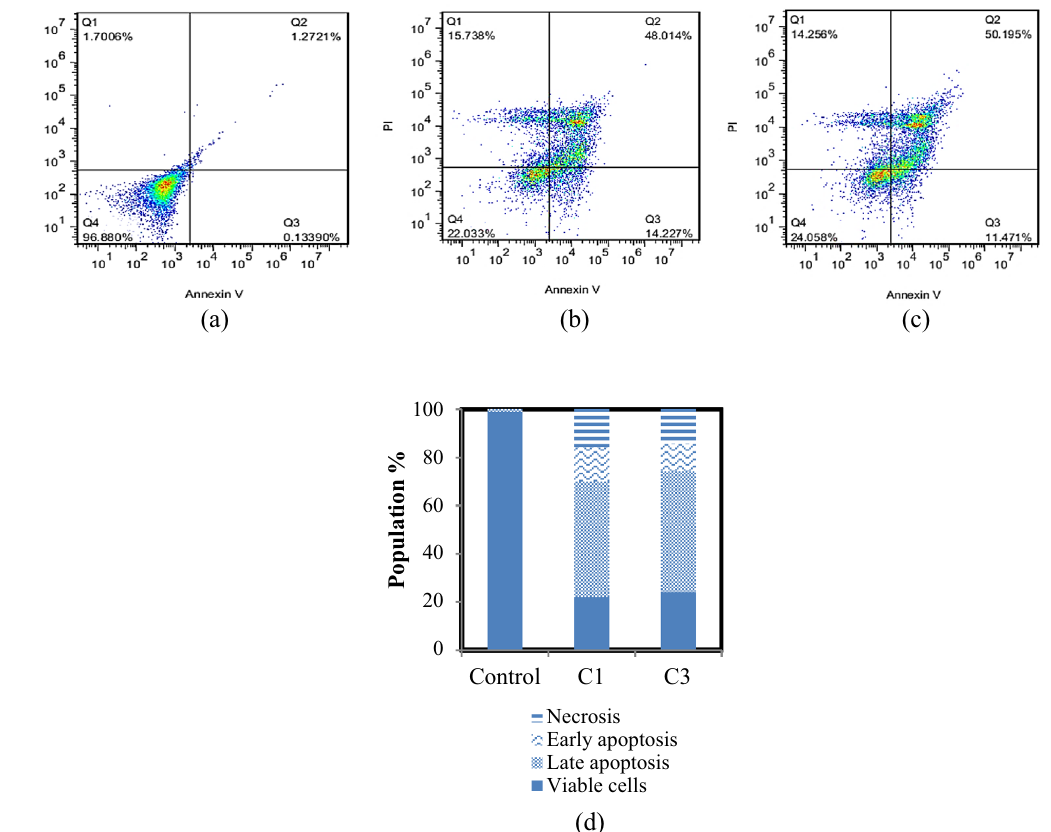
Figure 7. Effect of complexes on cell apoptosis for 24 h. Quantification of Annexin V and PI double-stained A375 cells after treatment with ( a ) Vehicle control, ( b ) C1, and ( c ) C3 at IC 50 concentrations by flow cytometric. ( d ) Populations for cell apoptosis.